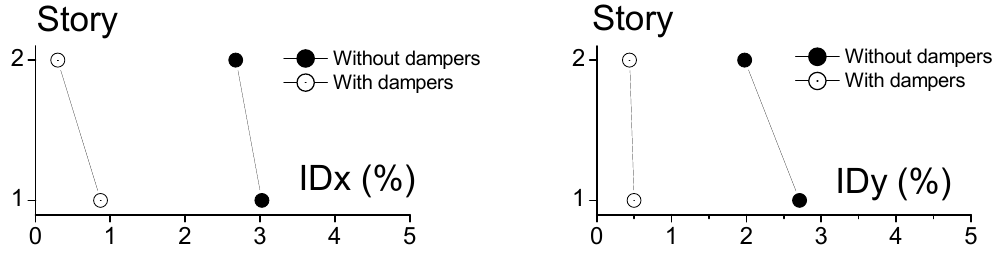
Figure 21. Response of the structure with and without SMA dampers.